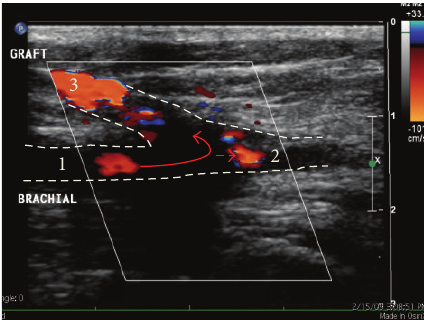
Figure 4: Operative photograph showing the proximal (1) and distal (2) native brachial artery. The anastomosis has been opened and reveals the metallic stent traversing the anastomosis and coursing up the graft (3). This required excision of the anastomosis and repair with a PTFE cuff.